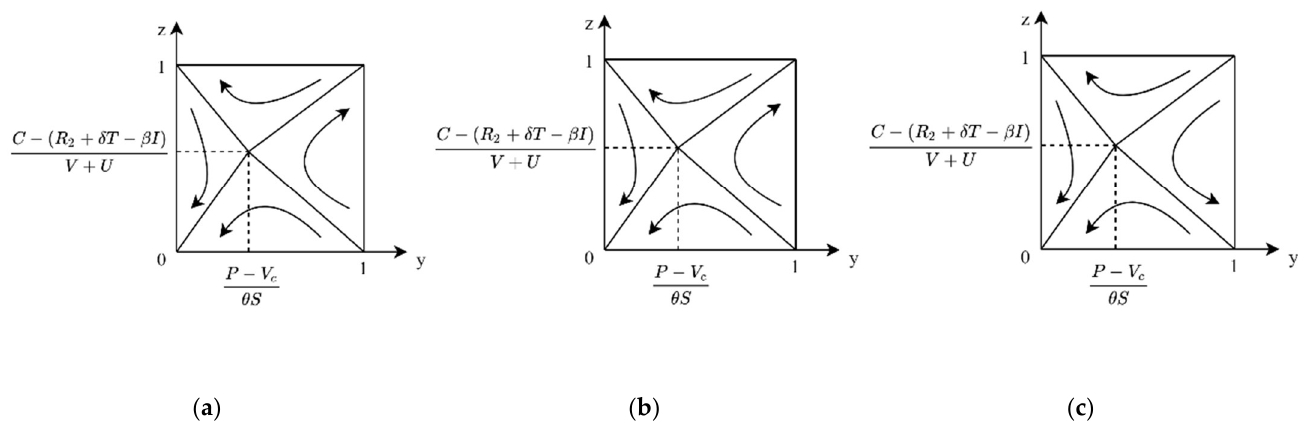
− ( R + δ T + β I ) > 2 V + U